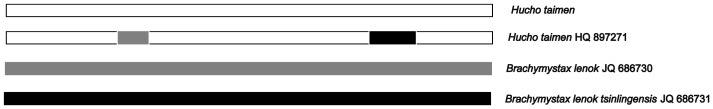
Schematic representation of the recombination events in the mitochondrial DNA of Hucho taimen from the Hutou range (GenBank HQ897271).The top parental sequence is from H. taimen (our study); the two bottom parental sequences are from B. lenok (first recombination event, in grey) and B. lenok tsinlingensis (second recombination event, in black).